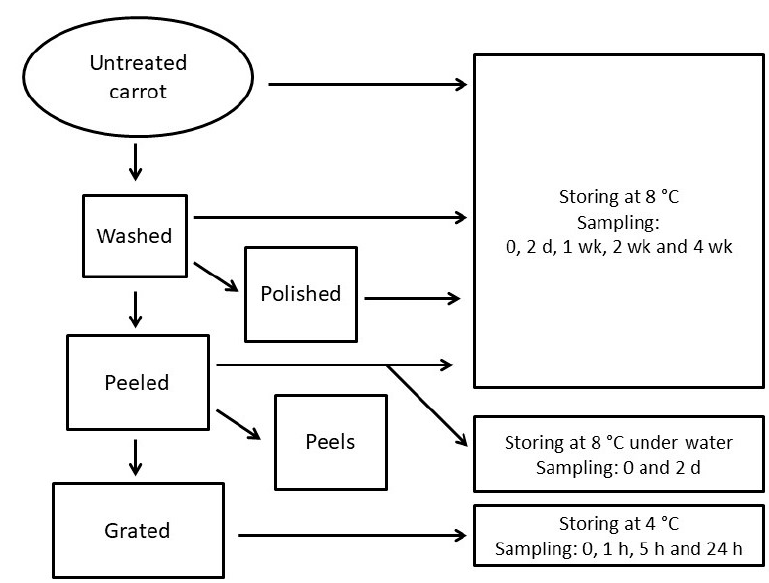
Figure 1. Scheme of carrot processing.